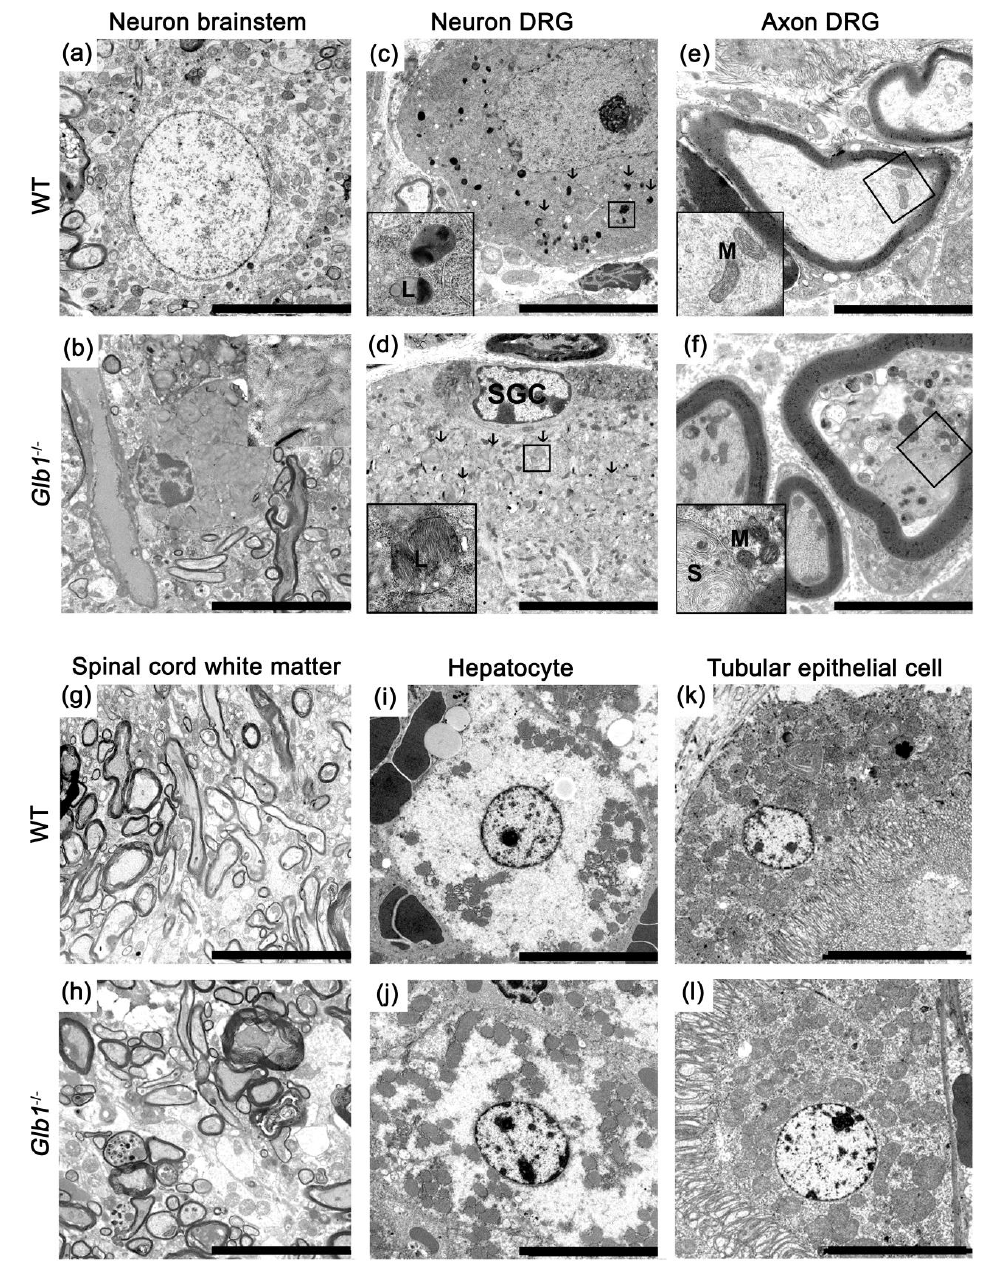
Figure 5. Transmission electron microscopy. ( a ) Brainstem neuron of a wildtype (WT); ( b ) brainstem neuron of an eight-month-old Glb1 -/- mouse; ( c ) dorsal root ganglion (DRG) neuron of a WT with normal lysosomes (L, insert); ( d ) DRG neuron of a Glb1 -/- mouse with lysosomal lamellated storage material (arrows and insert); adjacent satellite glial cell (SGC) without storage material; ( e ) axons from WT DRG with regularly structured neurofilaments and microtubules with few mitochondria (M, insert); ( f ) axons in a DRG from an 8-month-old Glb1 -/- mouse with lamellar storage material in lysosomes (S) and a relatively high number of mitochondria (M, insert); ( g , h ) myelin in the spinal cord white matter of eight-month-old WT and Glb1 -/- mice; ( i , j ) hepatocytes of eight-month-old WT and Glb1 -/- mice; ( k , l ) renal tubular epithelial cells of eight-month-old WT and Glb1 -/- mice. Bars: ( a – d ), ( g – l ): 10 µm, ( e , f ): 5 µm.